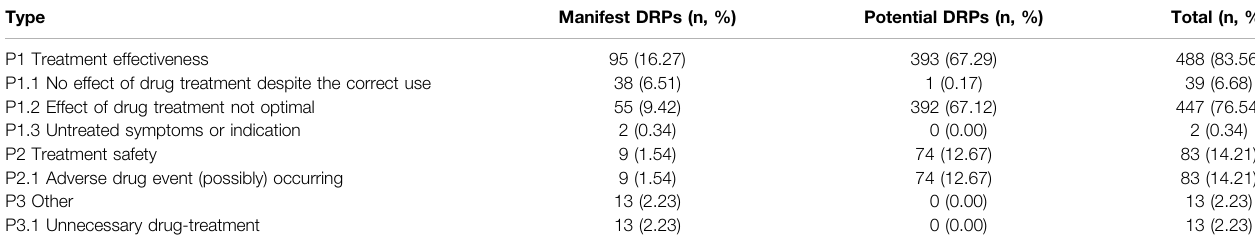
TABLE 2 | The type distribution of DRPs in children with chronic diseases in the